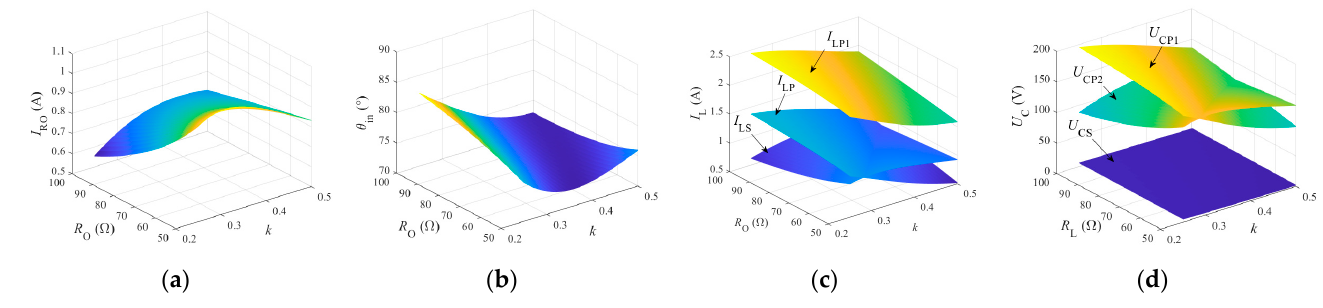
Figure 7. Main electrical values of CCO-type IPT system in case B: ( a ) output current; ( b ) input impedance angle; ( c ) current stresses on inductor and coils; ( d ) voltage stresses over capacitors.